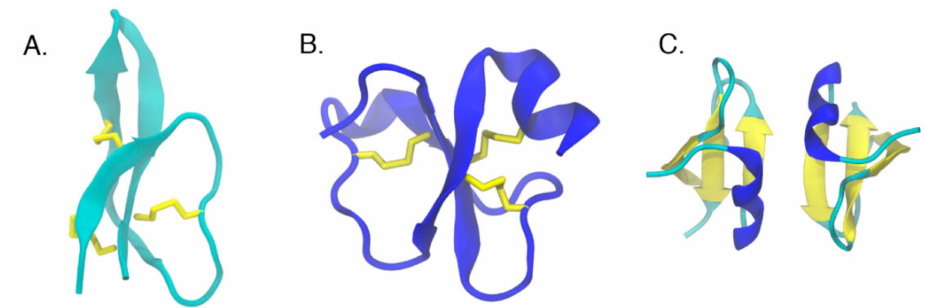
Figure 3. Examples of cyclic peptides with a β -sheet core. ( A ) Solution structure of human defensin 5 (2lxz) [27], ( B ) crystal structures of crotamine (4gv5) [38], ( C ) and human β -defensin-2 (1fd3) [20]. Disulfide bridges holding the β -strands together are shown in yellow stick